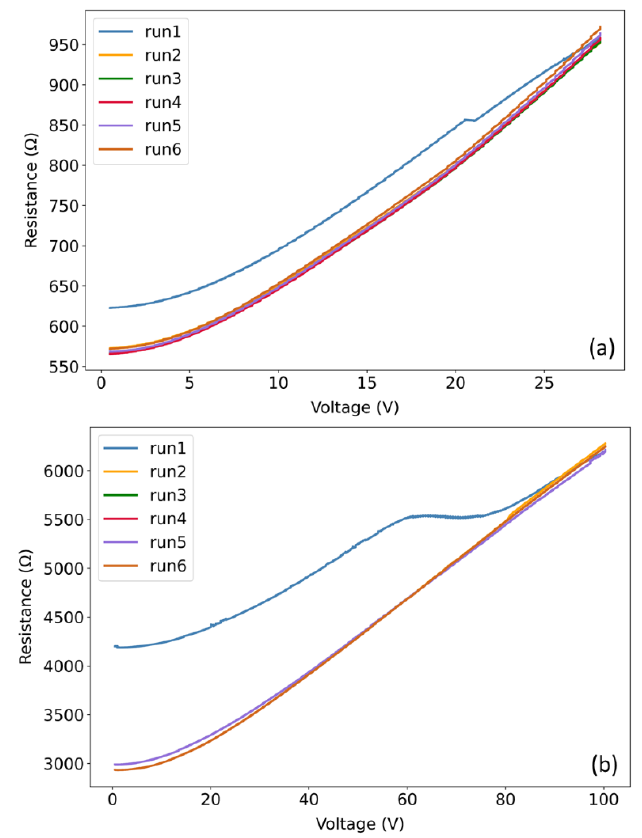
Figure 2. Measured stripe resistance vs. voltage in steps of 0.1 V. Each voltage step was held constant for 10 s. ( a ) Au stripe over the voltage range from 0.5 to 30 V; ( b ) Pt stripe over the voltage range from 0.5 to 100